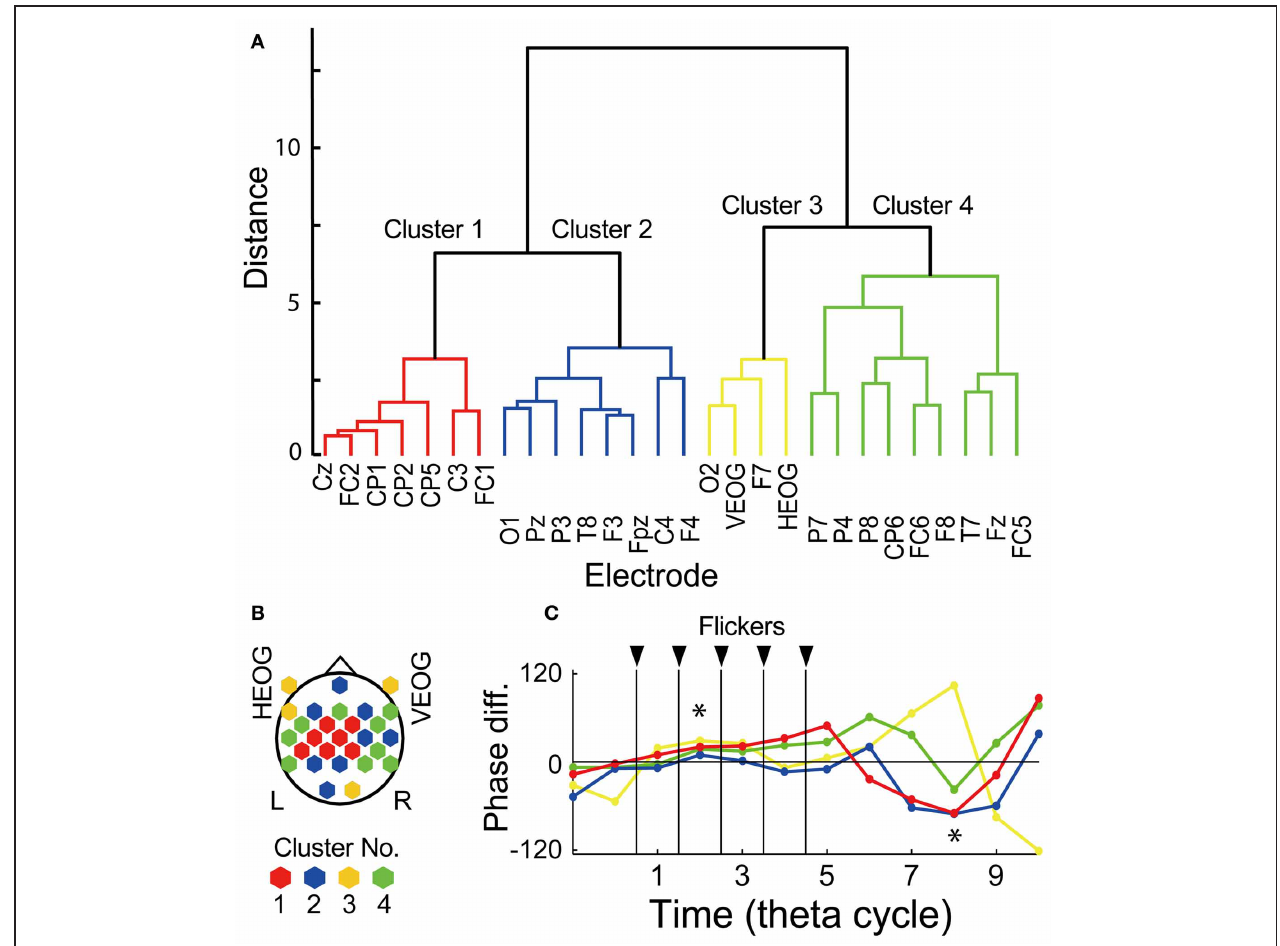
against that in the Miss condition in each cluster. Red, blue, yellow, green indicate cluster 1, 2, 3, and 4, respectively. Asterisks indicate time periods in which mean EEG phase in the Hit condition against that in the Miss condition of all electrode showed significant difference from 0 ◦ ( p < 0 . 05, Bonferroni